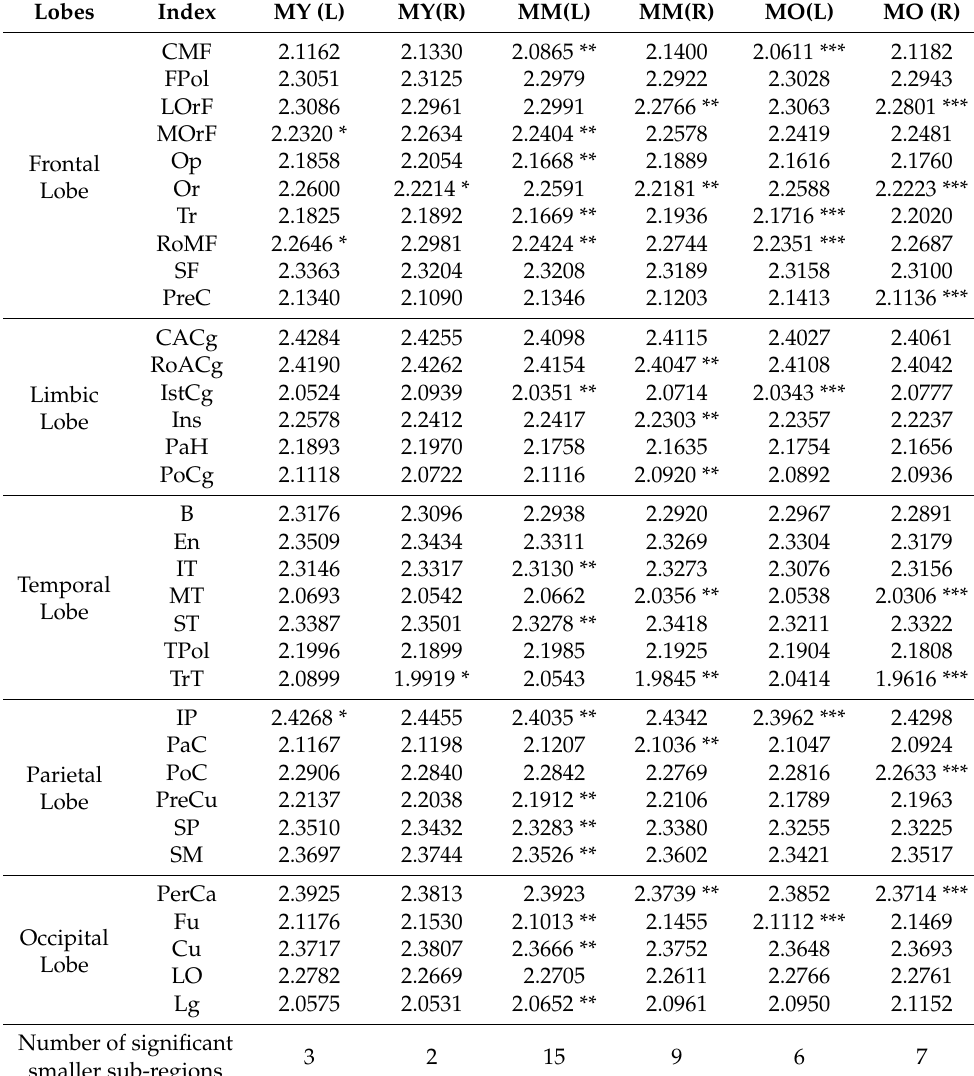
Table 4. Subregion fractal dimension (FD) values in men of different